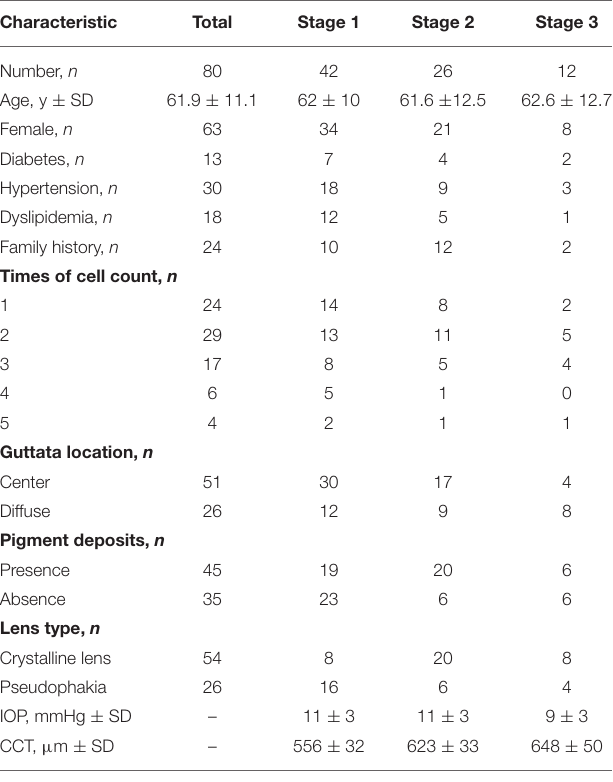
TABLE 1 | Demographic data and corneal